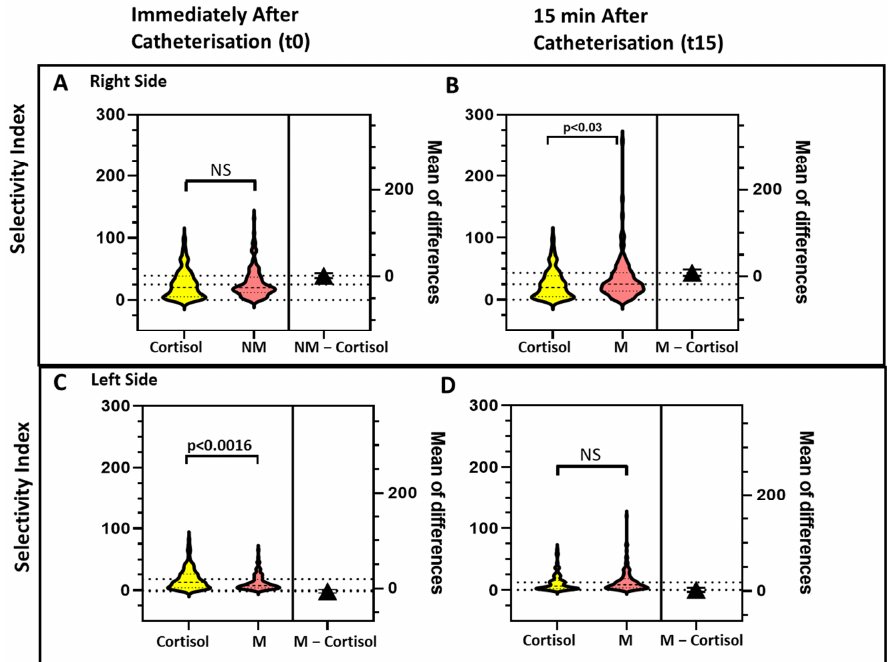
Figure 4. The violin plots show the values of the selectivity index for cortisol (SI C ) and for normetanephrine (SI NM ), measured immediately after starting catherization (Panels A and C ) and 15 min afterward (Panels B and D ), on the right side (Panels A and B ) and left side (Panels C and D ). The SI NM was higher at baseline than 15 afterward in a highly significant manner on both sides.